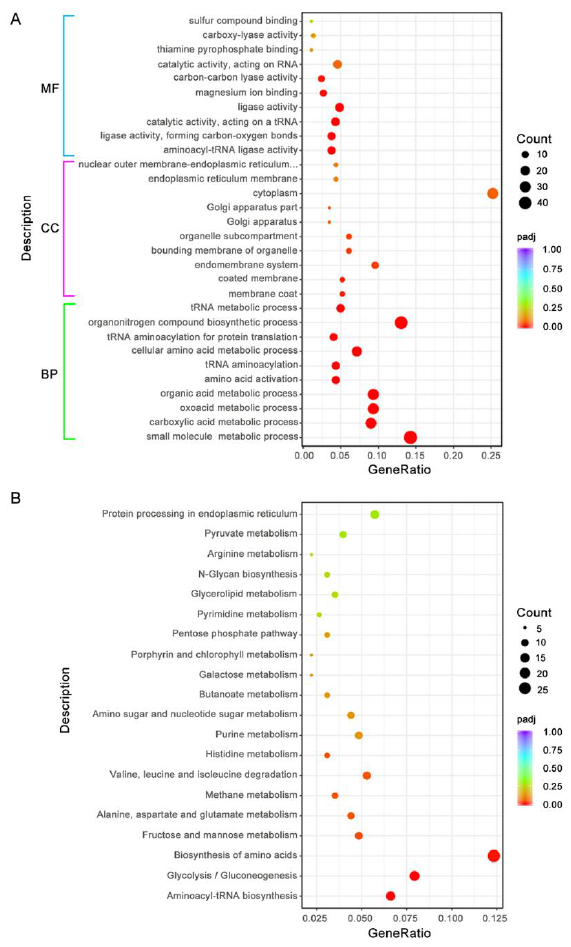
Figure 8. BdAtg1 influences multiple metabolic pathways. ( A ) Comparative Gene Ontology (GO) analysis of the differentially expressed genes (DEGs) between the transcriptome of LW03 and ∆ BdAtg1 . ( B ) Comparative KEGG pathways analysis of the DEGs between the transcriptome of LW03 and ∆ BdAtg1 .